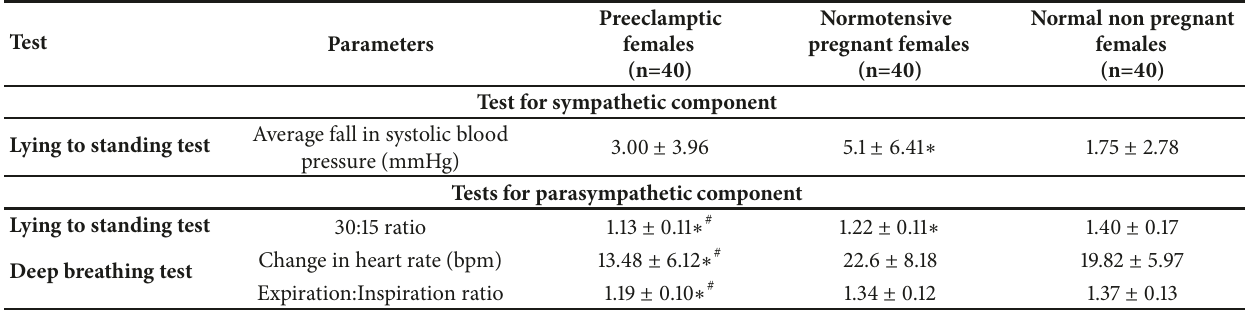
Table 2: Cardiovascular reflex tests in different